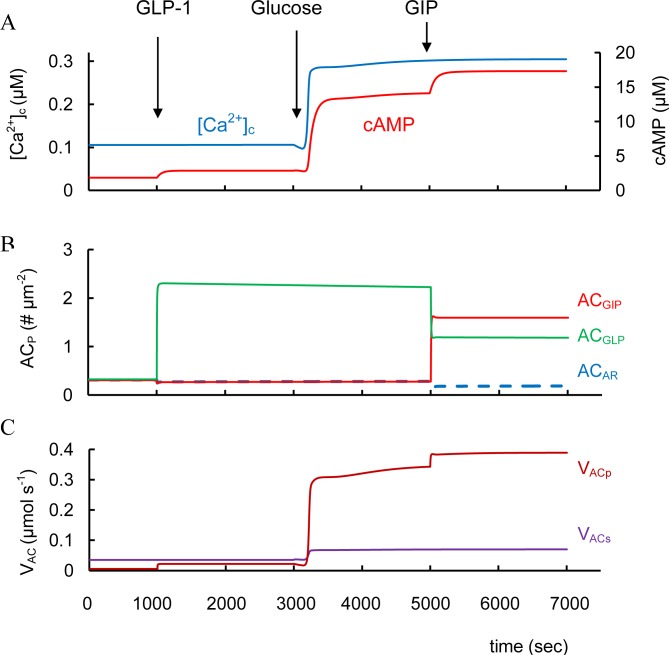
Simulation of GLP-1 and GIP action at low and high glucose levels.(A) Cytoplasmic [Ca2+]c and cAMP dynamics. (B) ACGLP, ACGIP and ACAR are the concentrations of complexes of AC on PM (ACP) bound with corresponding G-proteins activated by GLP-1R, GIPR and α2A adrenergic receptors. (C) VACp is G-protein and Ca2+ dependent AC activity on PM, VACc is the glucose and Ca2+-activated soluble AC activity that is independent on G-protein. At low glucose concentrations (3 mM) (left part) GLP-1 was increased from basal level (3.1e-7 μM) to 6.2e-4 μM at 1000 sec. Increased extracellular glucose level was simulated at 3000 sec (from 3 mM to 8 mM). Than GIP administration was modeled as the increased GIP from basal level (1.37e-6 μM) to 3.42e-3 μM at 5000 sec.